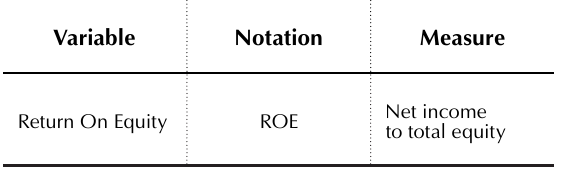
Table 8. Banking